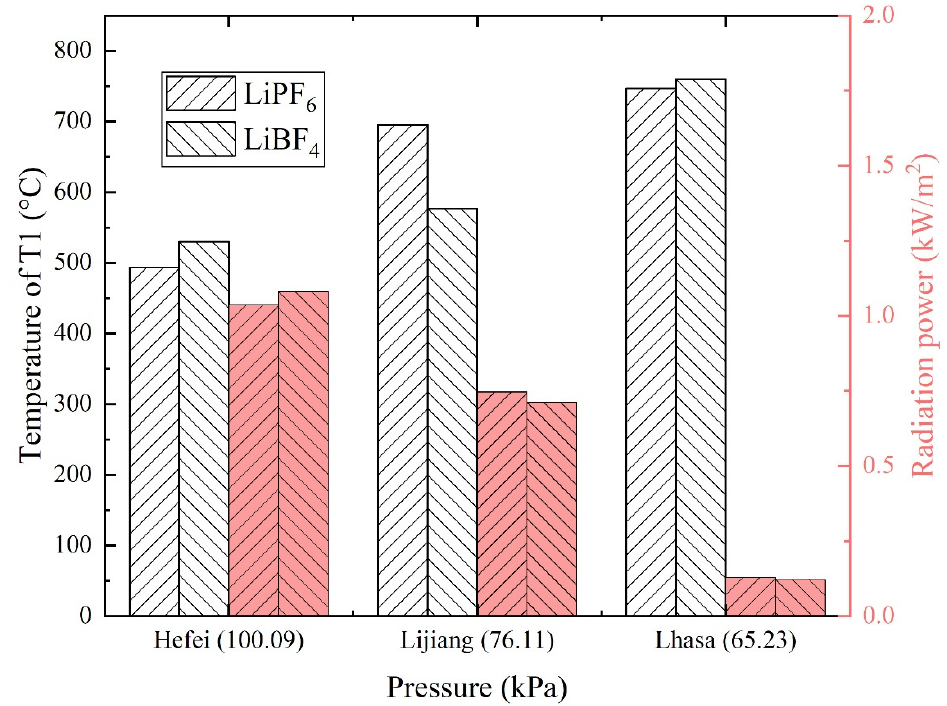
Figure 4. The average flame temperature and radiation power of the two samples at different pressures during the stable combustion stage.